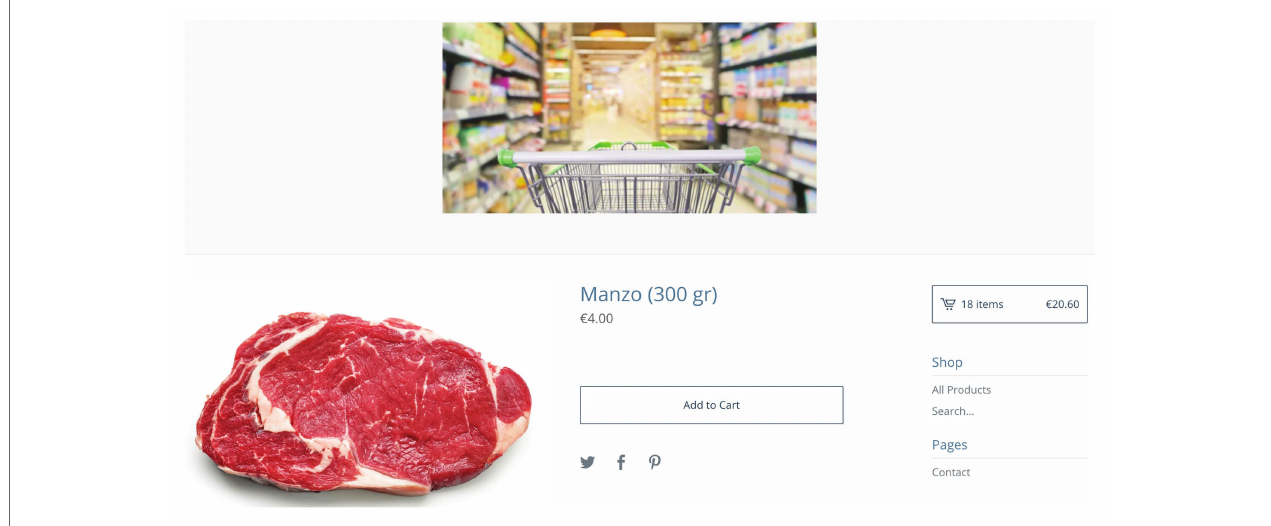
FIGURE 2 | Screenshot of the virtual supermarket. For example, one-item of beef (“Manzo”) corresponded to 300 g. Participants could add to cart the products they wished to buy as many times they wanted within the money range they were